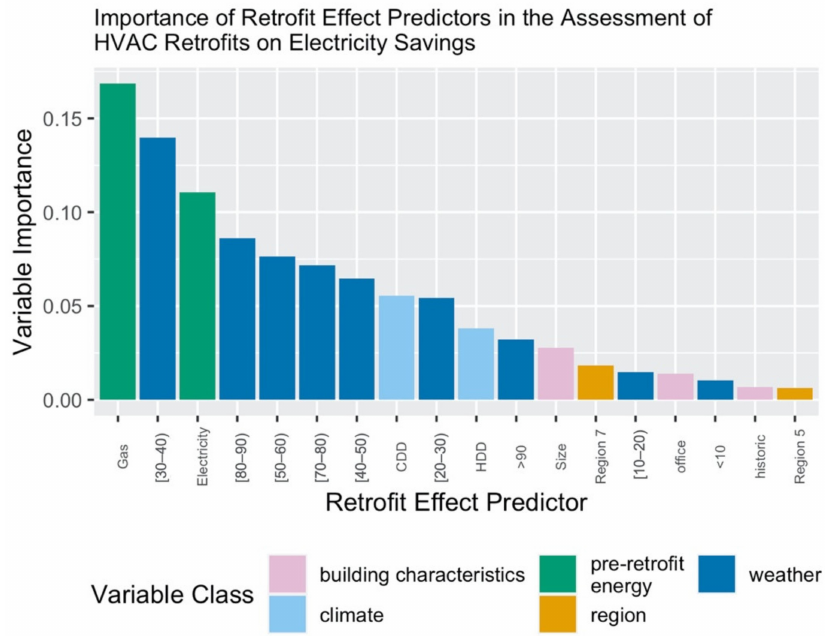
Figure 19. Variable importance of retrofit effect predictors predicting the effect of HVAC retrofits on annual electricity use.